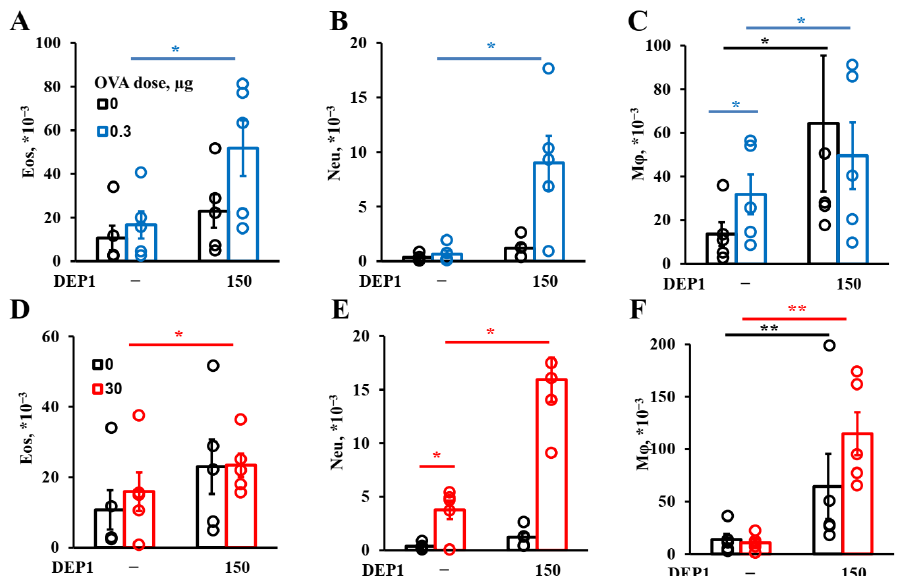
Figure 3. Cell response to DEPs. BALB/c mice were immunized with a low dose of OVA, 0.3 µg ( A – C ), or high dose, 30 µg ( D – F ), alone or with 150 µg of DEP1. After this, the mice were challenged three times a week for two weeks with 250 µg of OVA and sacrificed. BALs were taken, and the eosinophils (Eo), neutrophils (Neu), and alveolar macrophages (Mϕ) were quantified with flow cytometry. The experiment was performed three times. Representative data are from one out of three independent experiments. Significant differences vs. PBS are shown with black bars; those vs. 0.3 µg of OVA with blue ones; and those vs. 30 µg of OVA with red bars (* — p < 0.05; ** — p < 0.01). The graphs show the data from three representative experiments (total number of mice included in analysis from all experiments n = 5 per group). The data indicate biological replicates obtained from individual mice.